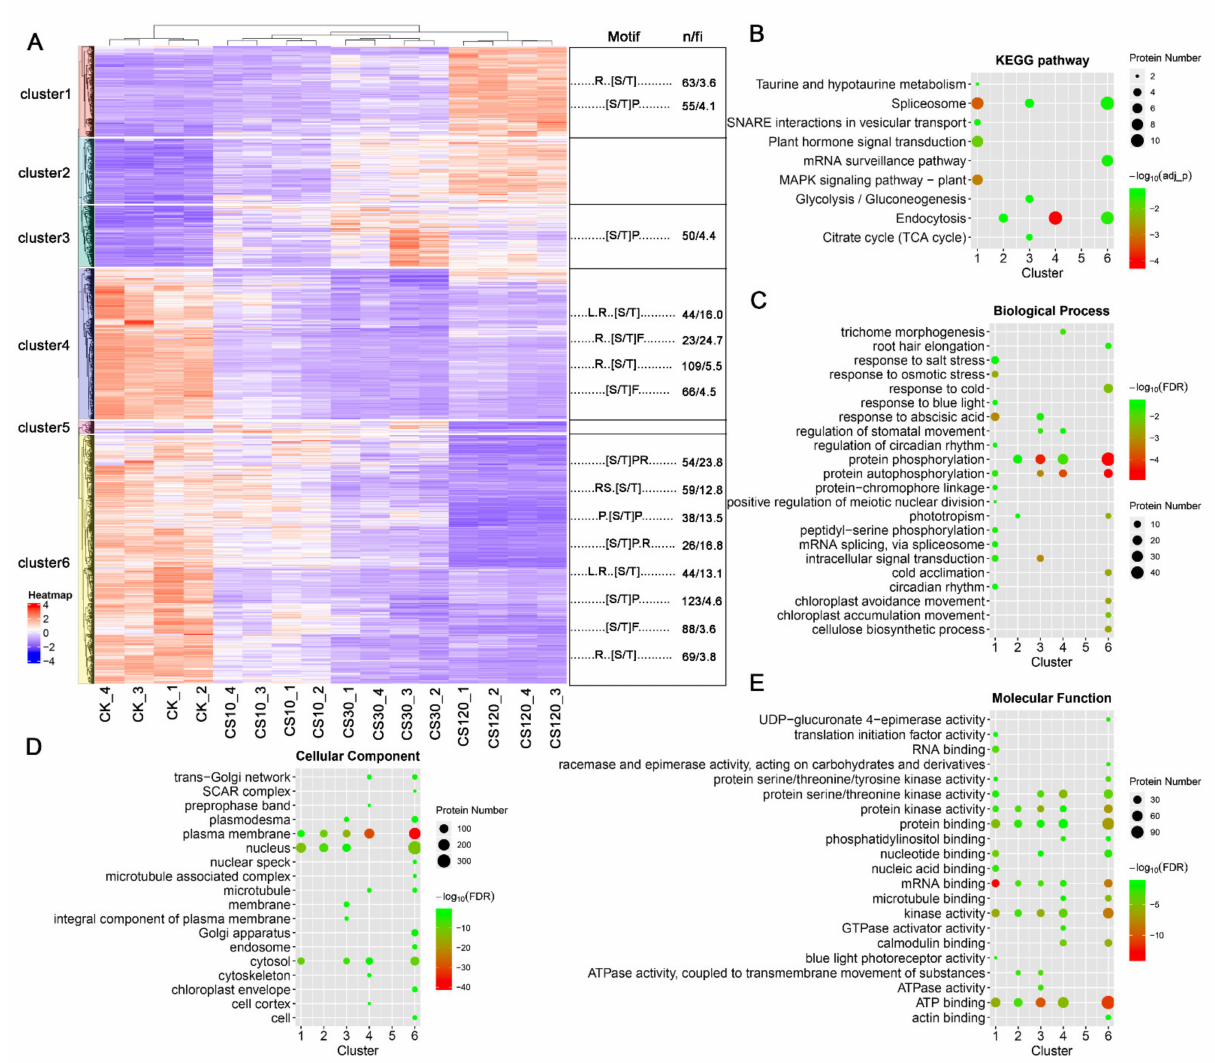
Figure 3. Clustering analysis of cold-responsive phosphopeptides. ( A ) HCA analysis of cold-responsive phosphopeptides (left) and phosphorylation site motif analysis of each cluster (right), “n” indicates the number of p-sites with the motif and “fi” is an indicator of the enrichment level of the extracted motifs and is calculated as (foreground matches/foreground size)/(background matches/background size). KEGG pathway enrichment ( B ) and GO enrichment analysis ( C – E ) of proteins with cold-responsive phosphopeptides belonging to each cluster were